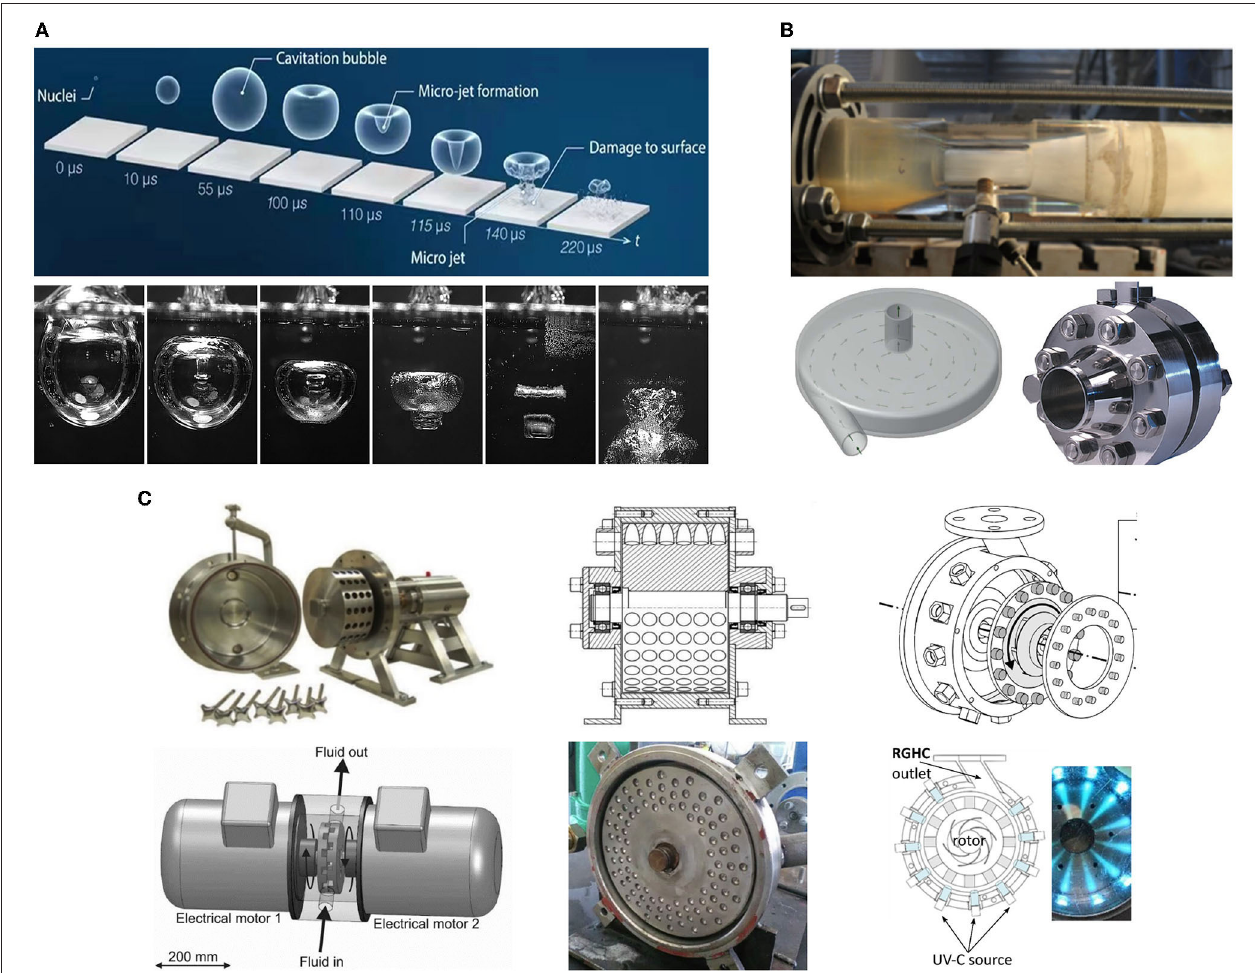
FIGURE 1 | Life cycle of a cavitation bubble (A) (7, 8), conventional non-rotational hydrodynamic cavitation reactor (NRHCRs) (B) , and representative advanced rotational HCRs (ARHCRs) (C)